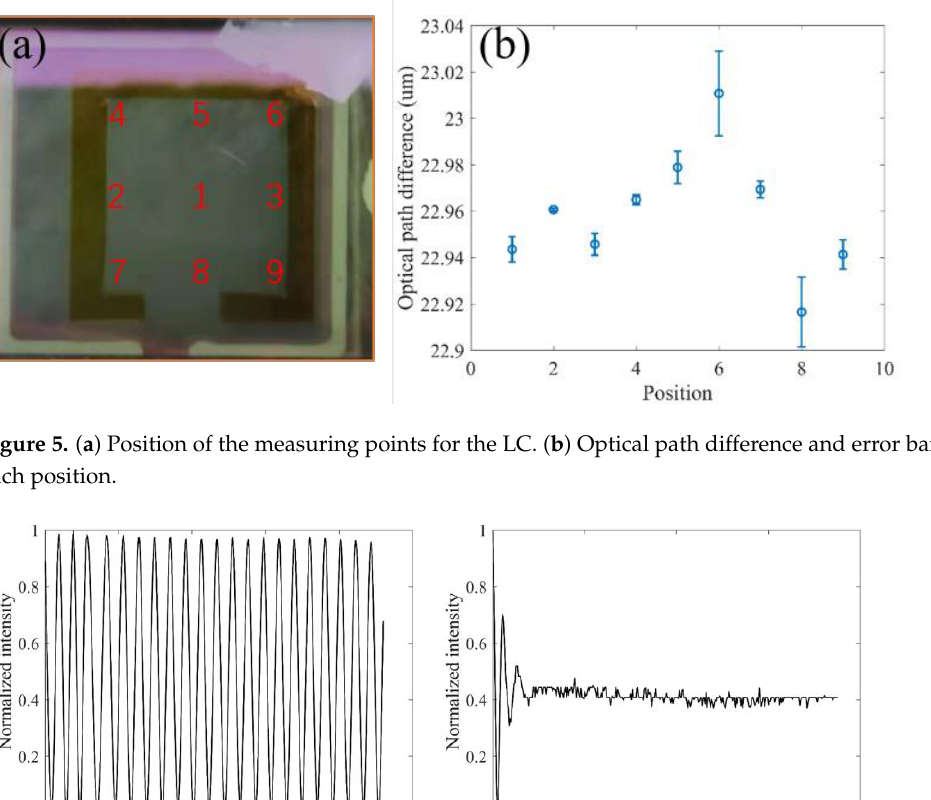
Figure 5. ( a ) Position of the measuring points for the LC. ( b ) Optical path difference and error bar at each position.